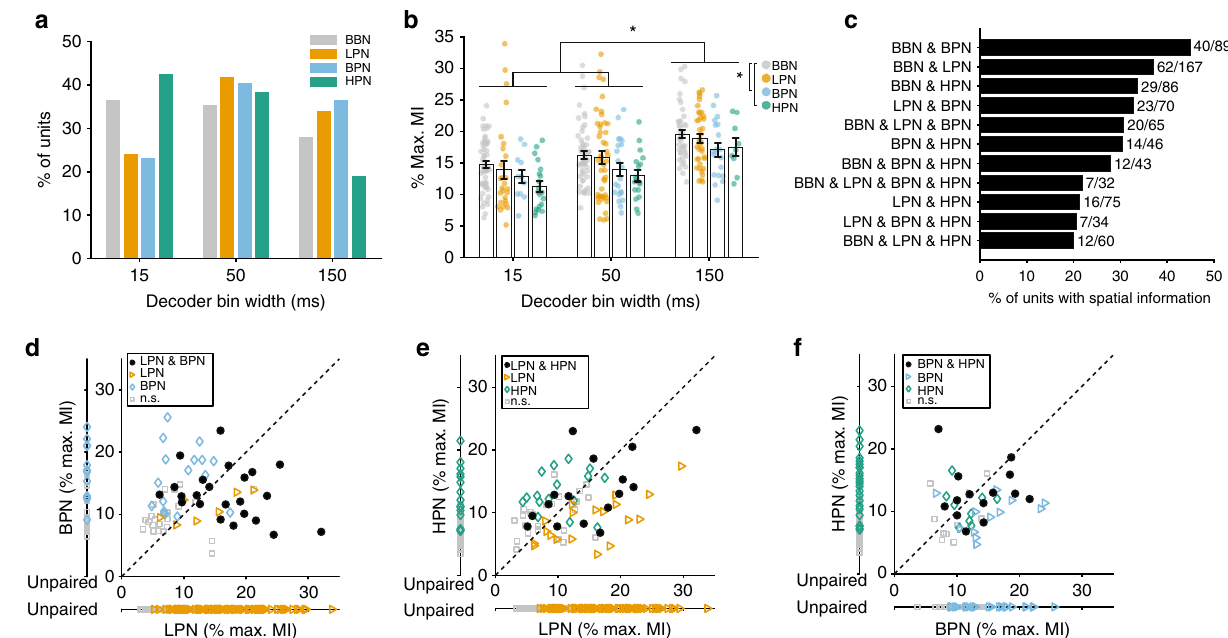
Fig. 5 Comparison of spatial information in broadband and cue-restricted conditions. The amount of spatial information (MI) from stimuli with limited cues was compared with those where all cues were present (BBN) and between pairs of limited cue conditions. a Distribution of best decoder bin widths for all spatially informative units (BBN ( N = 153), LPN (112), BPN (52), HPN (47)). b Mean percentage of maximum MI ± s.e.m. of units from ( a ). The raw data are shown by coloured circles. Statistics: two-way ANOVA with Tukey – Kramer post-hoc pairwise comparisons, asterisk (*) shows p < 0.05. c Proportion of units that showed information (in any bin width) in each combination of stimulus conditions. d Comparison of the mean percentage of maximum MI of units recorded in both low-pass (LPN) and bandpass (BPN. Paired: both signi fi cant N = 23, LPN sig. = 7, BPN sig. = 17, neither sig. = 23. Unpaired: LPN sig. = 82, not sig. = 92, BPN sig. = 12, not sig. = 15). e Low-pass and high-pass (HPN, paired: both signi fi cant N = 16, LPN sig. = 19, HPN sig. = 16, neither sig. = 24. Unpaired: LPN sig. = 77, not sig. = 92, HPN sig. = 15, not sig. = 24) and ( f ) BPN and HPN (paired: both signi fi cant N = 14, BPN sig. = 13, HPN sig. = 9, neither sig. = 10. Unpaired: BPN sig. = 25, not sig. = 26, HPN sig. = 24, not sig. = 44) conditions. Units that were only recorded in one condition are plotted along a separate axis. Units with signi fi cant MI in both conditions are shown as black circles, signi fi cant MI in only one of the conditions is indicated by triangles and diamonds. Grey squares show units not signi fi cantly informative in either spatially modulated in both broadband and CSS conditions (Fig. 6b – e, paired T-test test, p = 0.642, N = 59) nor on the ERRF widths (Fig. 6f, paired T -test, p = 0.301). However, adding the